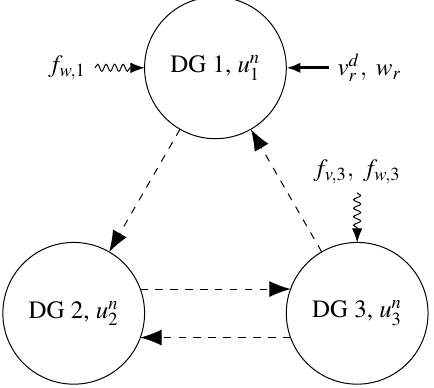
Figure 2. The modified 3-DG(distributed generator) microgrid